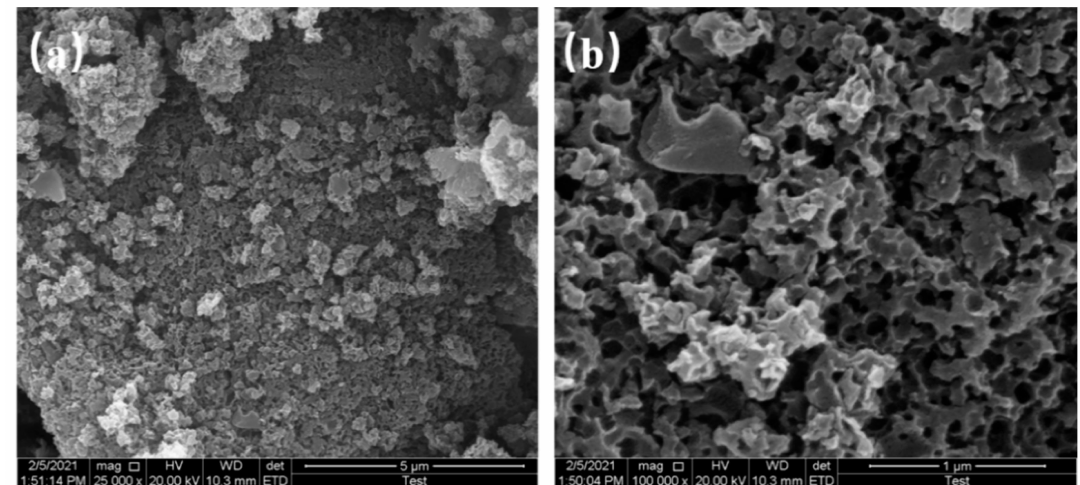
Figure 6. SEM images of 850 ◦ C at ( a ) 5 µ m resolution, ( b ) 1 µ m